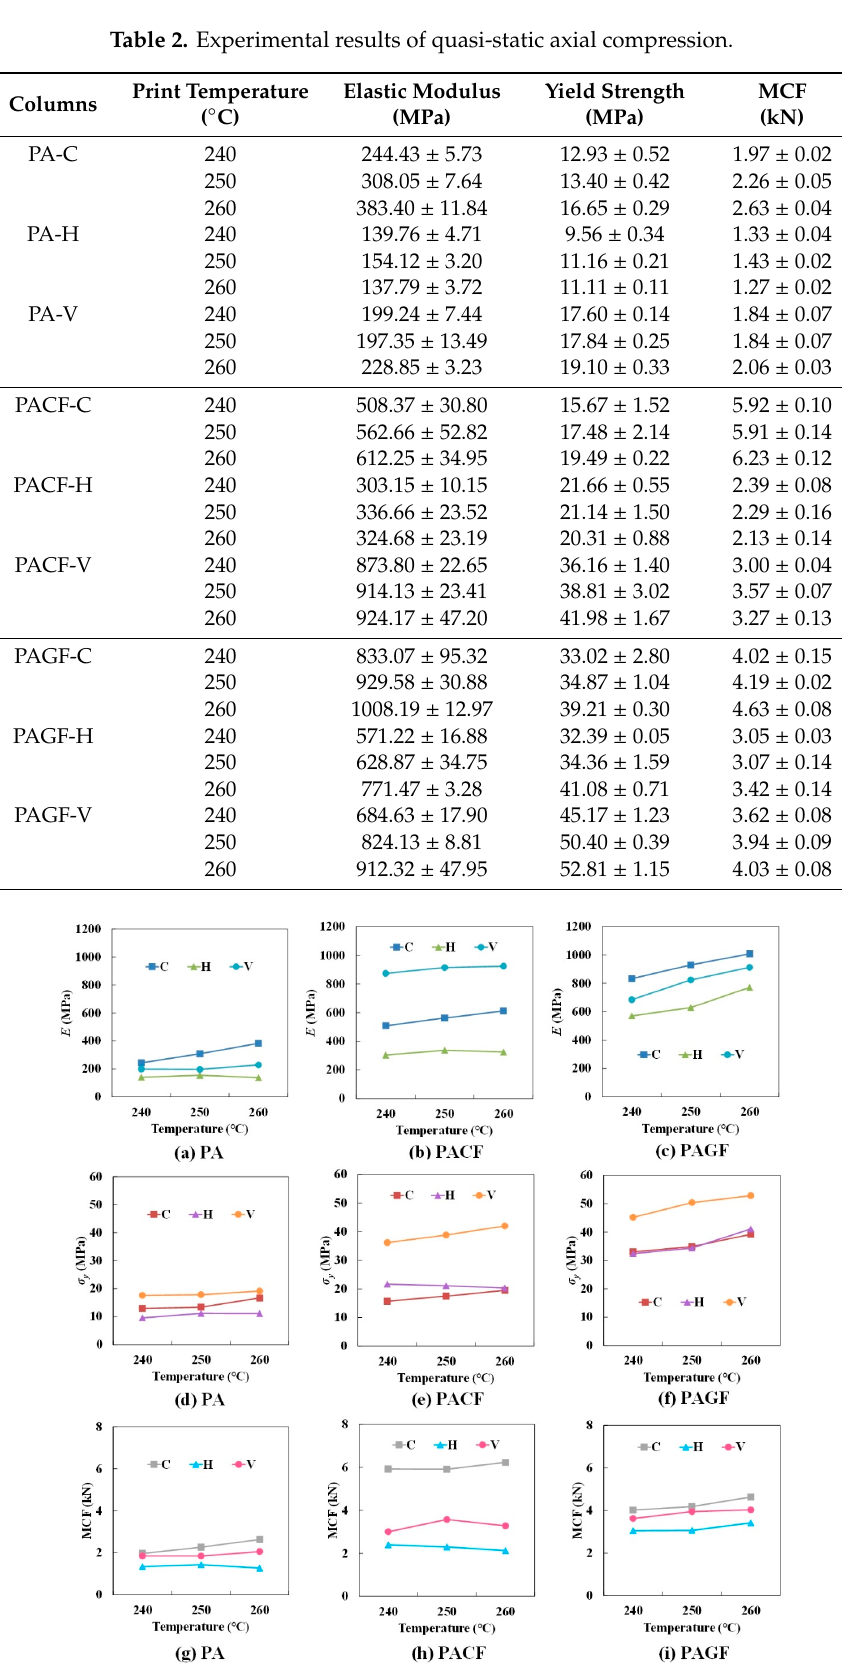
Figure 13. E ff ect of printing temperature on elastic modulus of: ( a ) PA; ( b ) PACF; ( c ) PAGF; and on yield strength of: ( d ) PA; ( e ) PACF; ( f ) PAGF; and MCF of: ( g ) PA; ( h ) PACF; ( i ) PAGF.